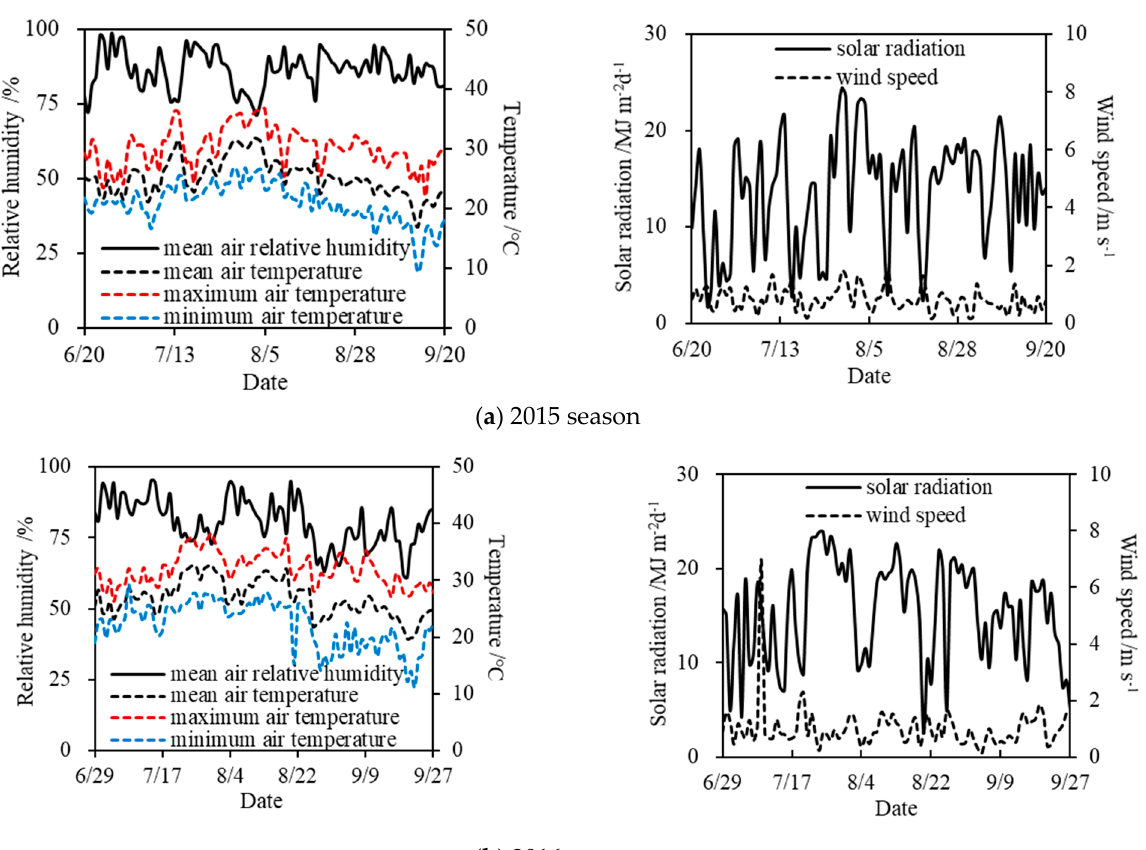
Figure 2. Daily meteorological elements at the station during the experimental periods of soybean in ( a ) 2015 season and ( b ) 2016 season.